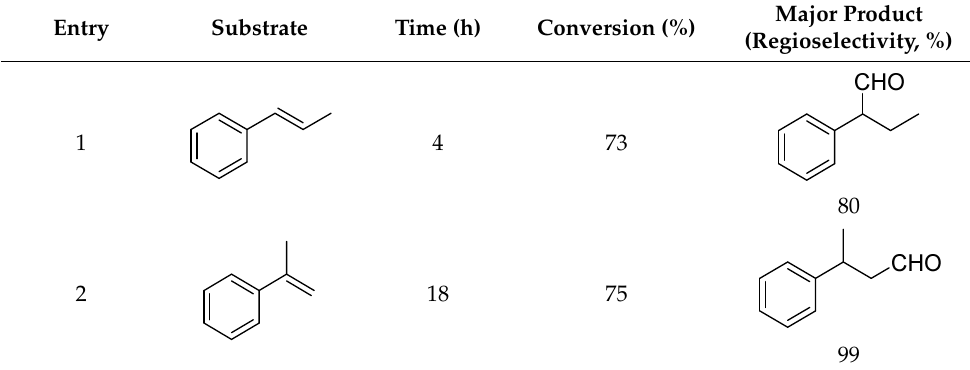
Table 1. Evaluation of monophosphite ligands L1 – L4 in Rh-catalysed hydroformylation of styrene a .